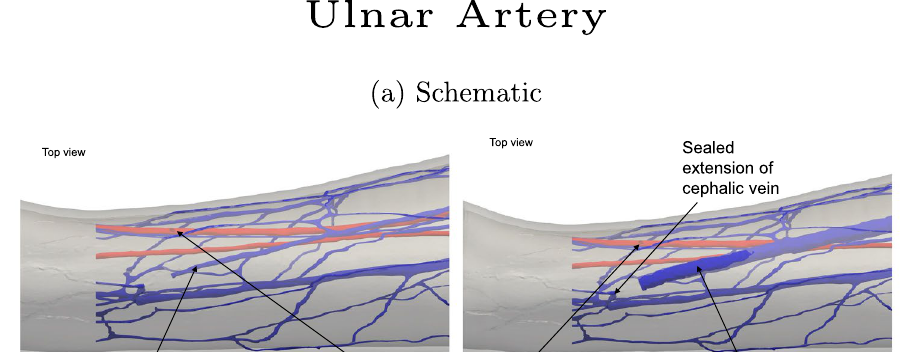
flow rates observed are solely due to the changes in vascular geometry caused by the creation of the fistula and the subsequent dilation of the cephalic vein. The 26% increase in outflow due to the dilation of the cephalic vein may be indicative of this enlarged vessel drawing flow from the other veins in the domain. In our study, the arterial domain was not dilated in response to the maturation of the fistula and the connection point on the radial vein remained at the same diameter (the dilation be accounted for in the connecting bed model). This meant that approximately 31% of the total arterial flow was passing through the fistula connection point, corresponding to 39% of the flow passing along the radial artery. With the cross-sectional area of the AVF connection point being only 31% of the radial outlet area, this would also suggest that the presence of the fistula enhances the flow exit- ing the arterial domain through this pathway. However, compared to observed data, the flow through the fistula recorded in our setting is far lower than what would be considered successful in a clinical setting. Such examples of ‘failed’ fistula are not uncommon in practice, both in general and for patients with vessels of similar size to those tested here 36 . In Wedgwood et al. 43 , a study of 71 patients who had an arteriovenous fistula created between the radial artery and cephalic vein is presented. The authors present a correlation between the diameter of the vein used to create the fistula and the flow rate through it. As indicated in Fig. 6 the healthy and pre-maturation data is consistent with that the data presented in Wedgwood et al. 43 , whilst the post-maturation flow rate is significantly less than what would be expected for a vessel of this size. In this plot we have used the average of the inlet and outlet radii of the cephalic vein. It is noted by Van Tricht et al. 34 that, for a radiocephalic arteriovenous fistula, a flow rate of at least 500 ml/ min is required to be successful (though it has been noted that such a criteria varies globally 22 ). This is around